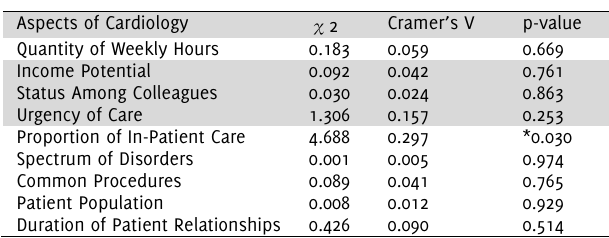
Table 4 . The Impact of Previous Electives on Understanding of Career-Related Aspects of Cardiology.